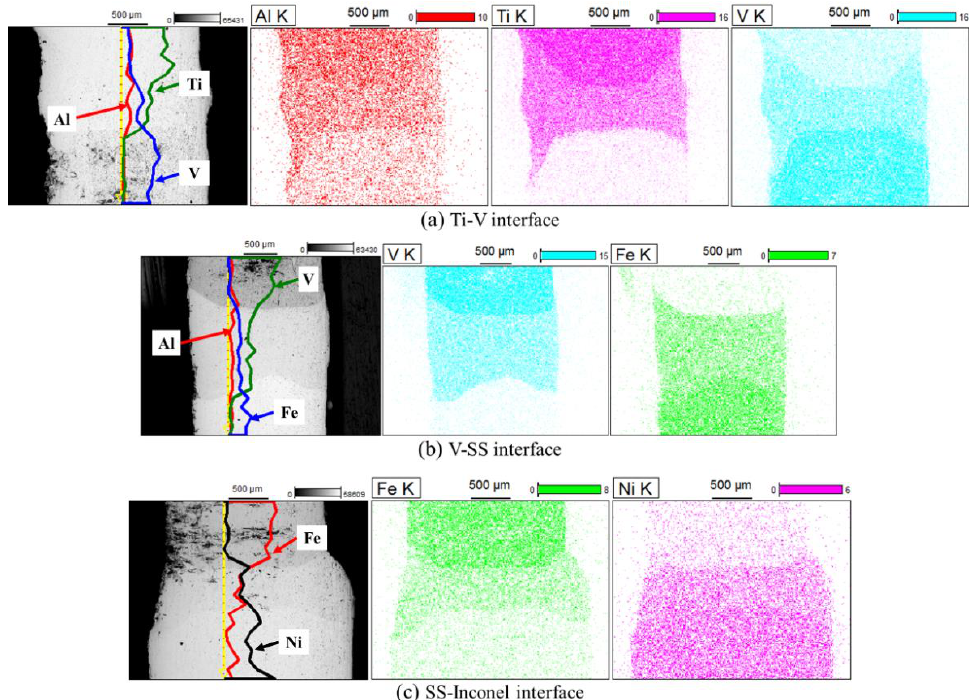
Figure 18. EDS maps of the specimen tested at Δσ = 140 MPa and runout (specimen 1).